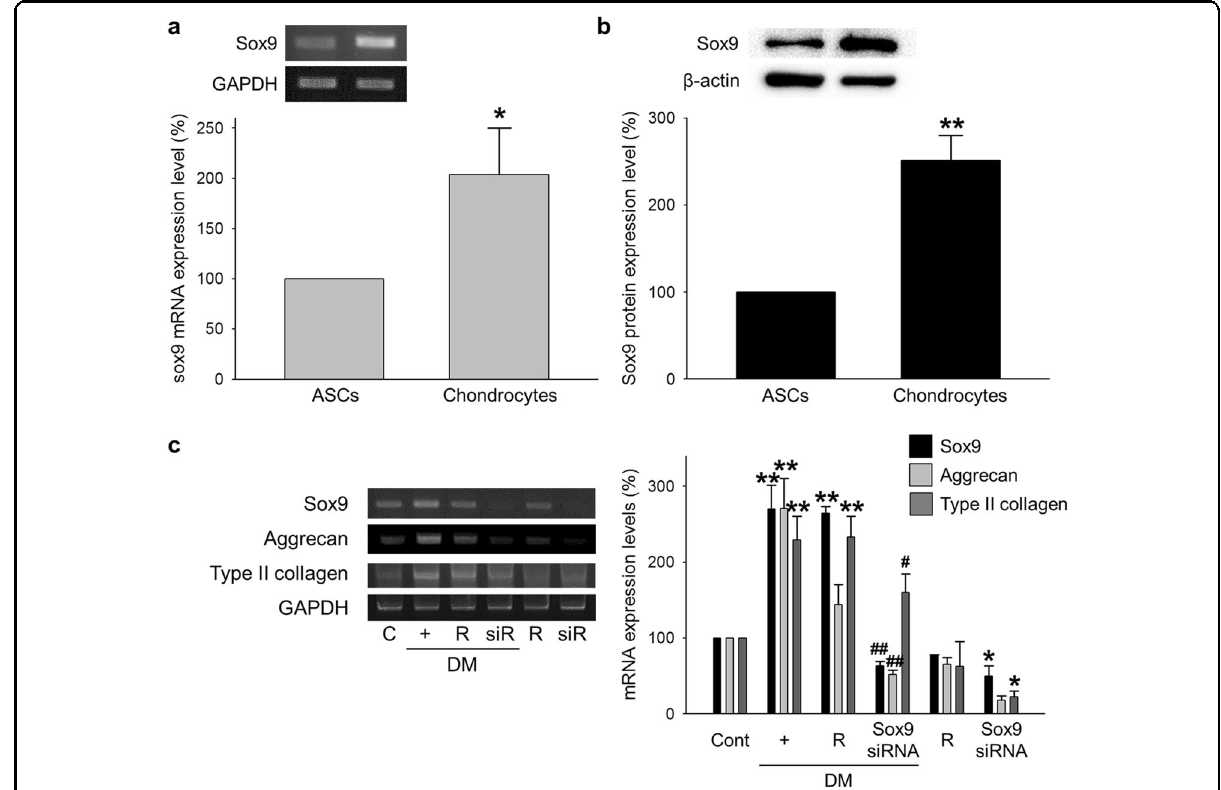
Fig. 1 Importance of Sox9 in chondrogenic differentiation. a , b mRNA and protein expression of Sox9 in ASCs and chondrocytes. Normalized by GAPDH and B-actin. * p < 0.05 compared to ASCs ** p < 0.001 compared to ASCs. n = 3. c ASCs were transfected with 50 nM Sox9 siRNA for 24 h and cultured in chondrocyte differentiation medium (DM). The cells were transfected with the Sox9 siRNA every 3 days for 16 days while cultured in DM. The mRNA expression of Sox9, Aggrecan, and Type II collagen in the Sox9 siRNA-transfected ASCs. C and Cont control, R reagent-transfected ASCs, siR Sox9 siRNA-transfected ASCs, DM chondrogenic differentiation induction medium. * p < 0.05, ** p < 0.001 compared to the control, # p < 0.05, ## p < 0.001 compared to the reagent-transfected and DM-treated ASCs. n =